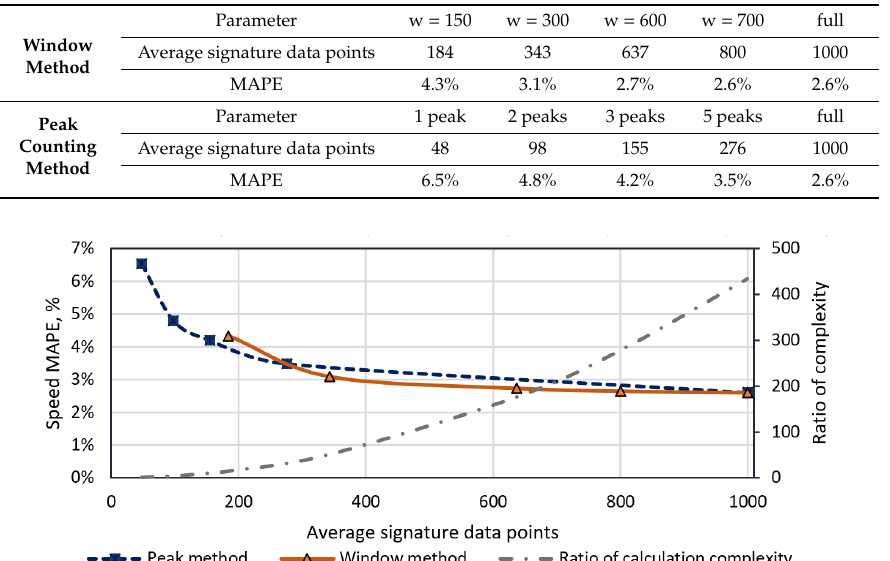
Table 4. An estimated speed MAPE comparison of the two cropping methods.